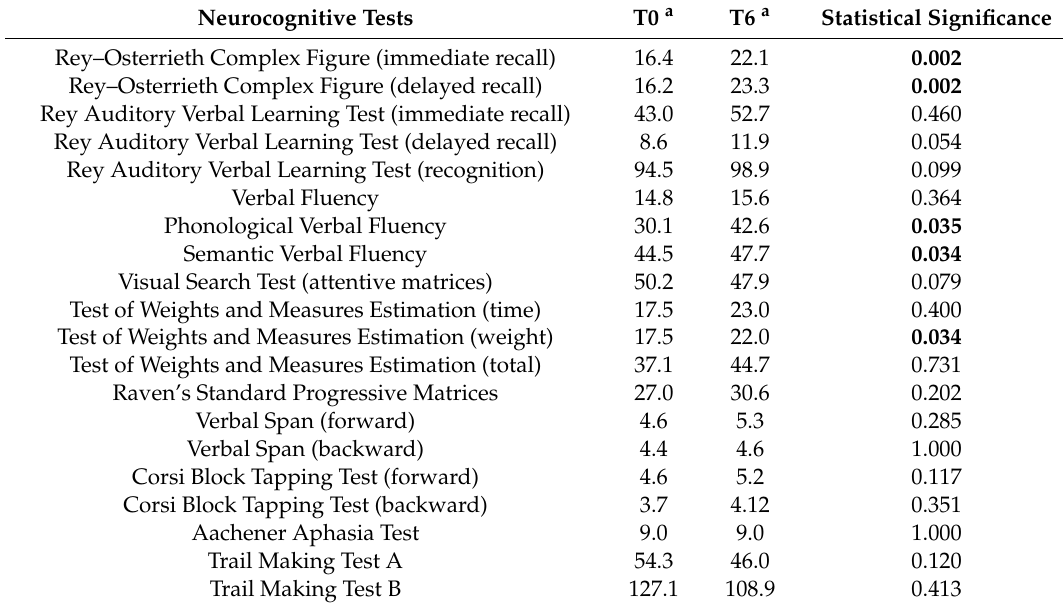
Table 2. Neurocognitive tests performance of HIV + participants. Neurocognitive Tests T0 a T6